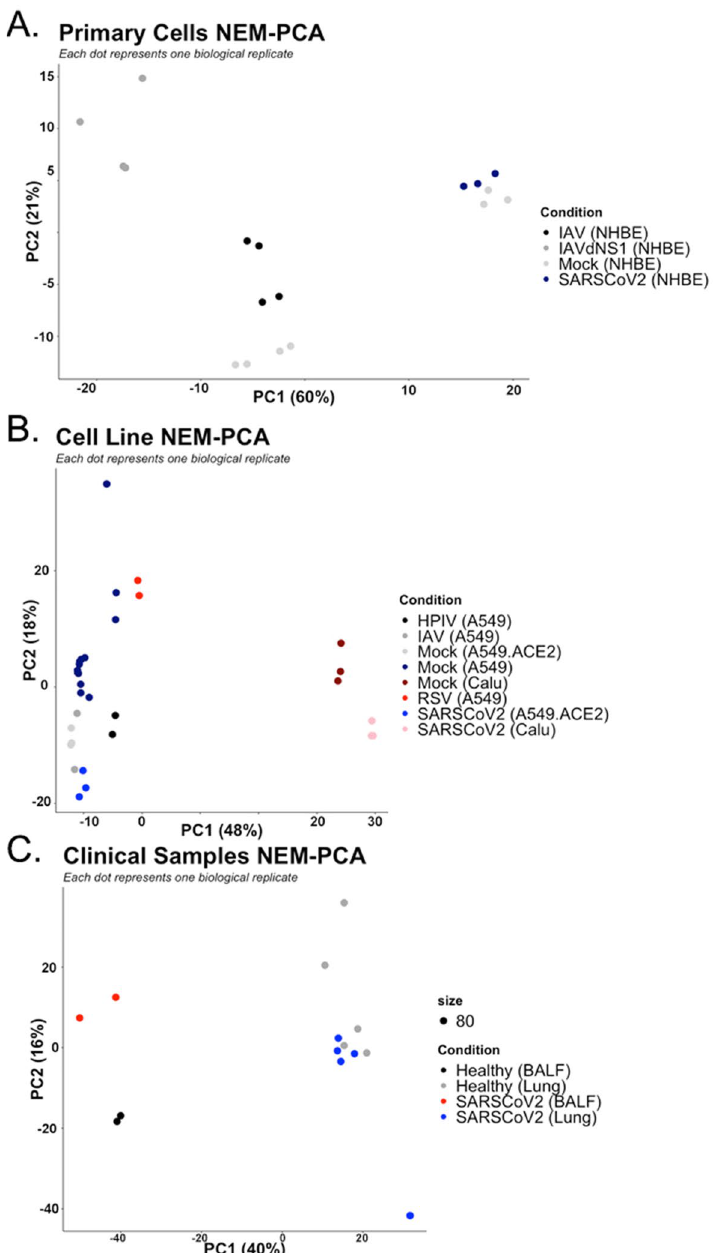
Figure 2. Principal component analysis of NEM expression data by primary cells ( A ), cell lines ( B ), and clinical samples ( C